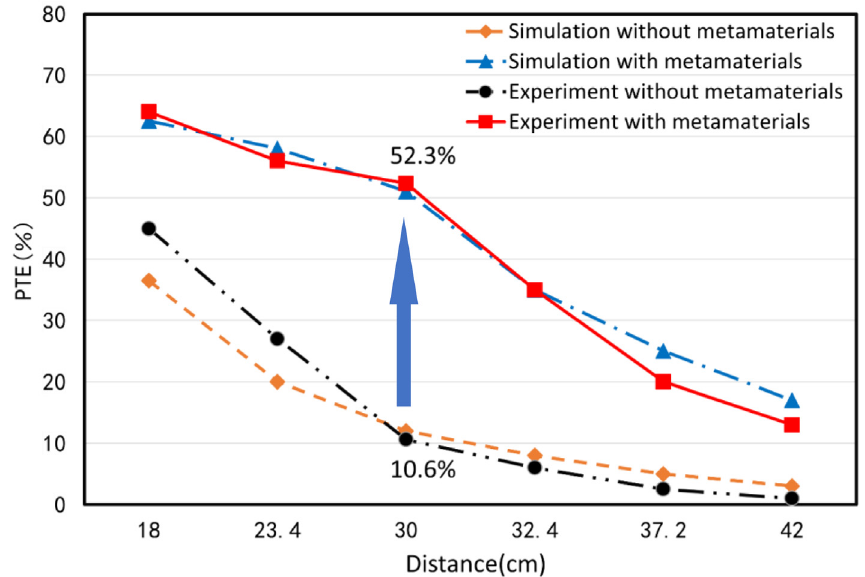
Fig. 2. Simulationandexperimentaltransmissionef fi